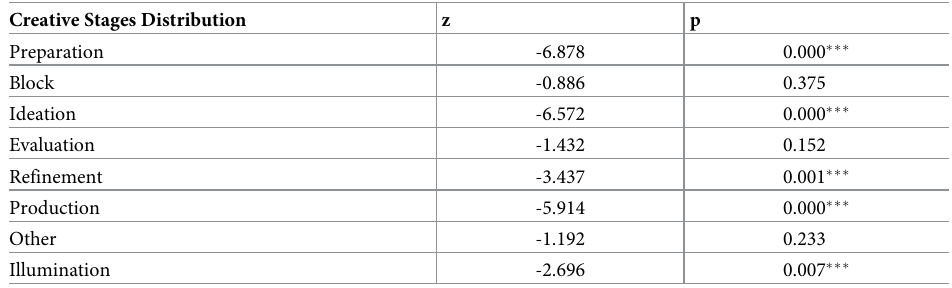
Table 4. Results of the Mann Whitney U test comparing the stationary state distribution of stages between the CPS and SPS